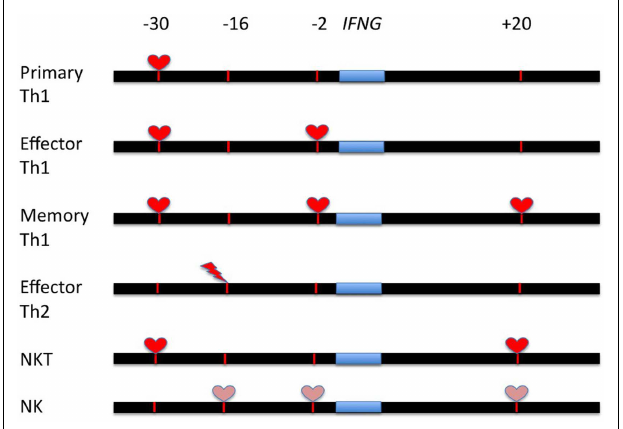
FIGURE 2 | Summary of the regulation of IFNG transcription by distal CNS at different stages of development inT cells and NK/NKT cells . Red hearts identify CNS’s that are absolutely required for IFNG transcription in the indicated cell lineage; pink hearts identify CNS’s that are partially required for IFNG transcription in the indicated cell lineage. Red lightning strikes identify CNS’s that repress IFNG